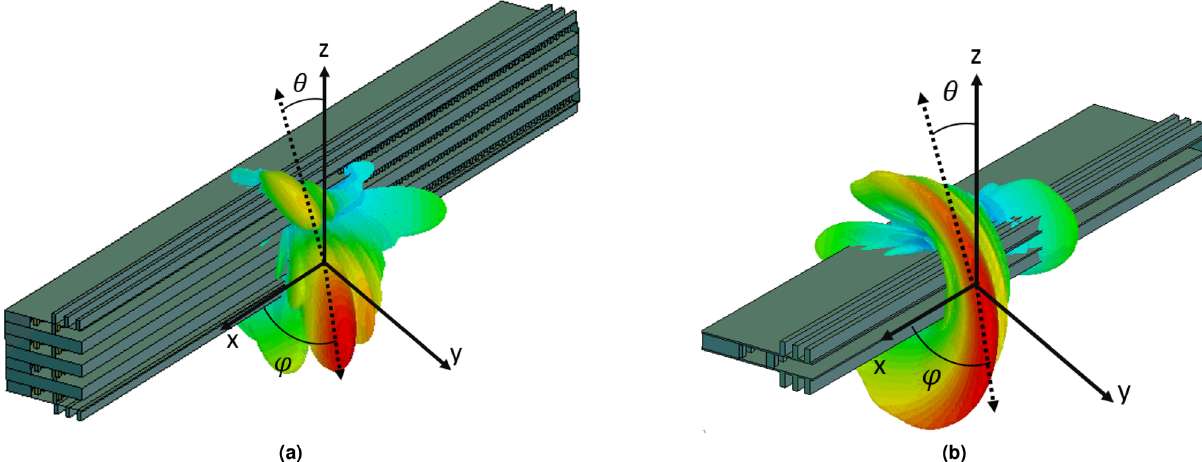
Figure 9. 3D representation of the simulated radiation pattern at 28 GHz for ( a ) the proposed array and ( b ) the leaky-wave antenna that was used as basic element of the array.